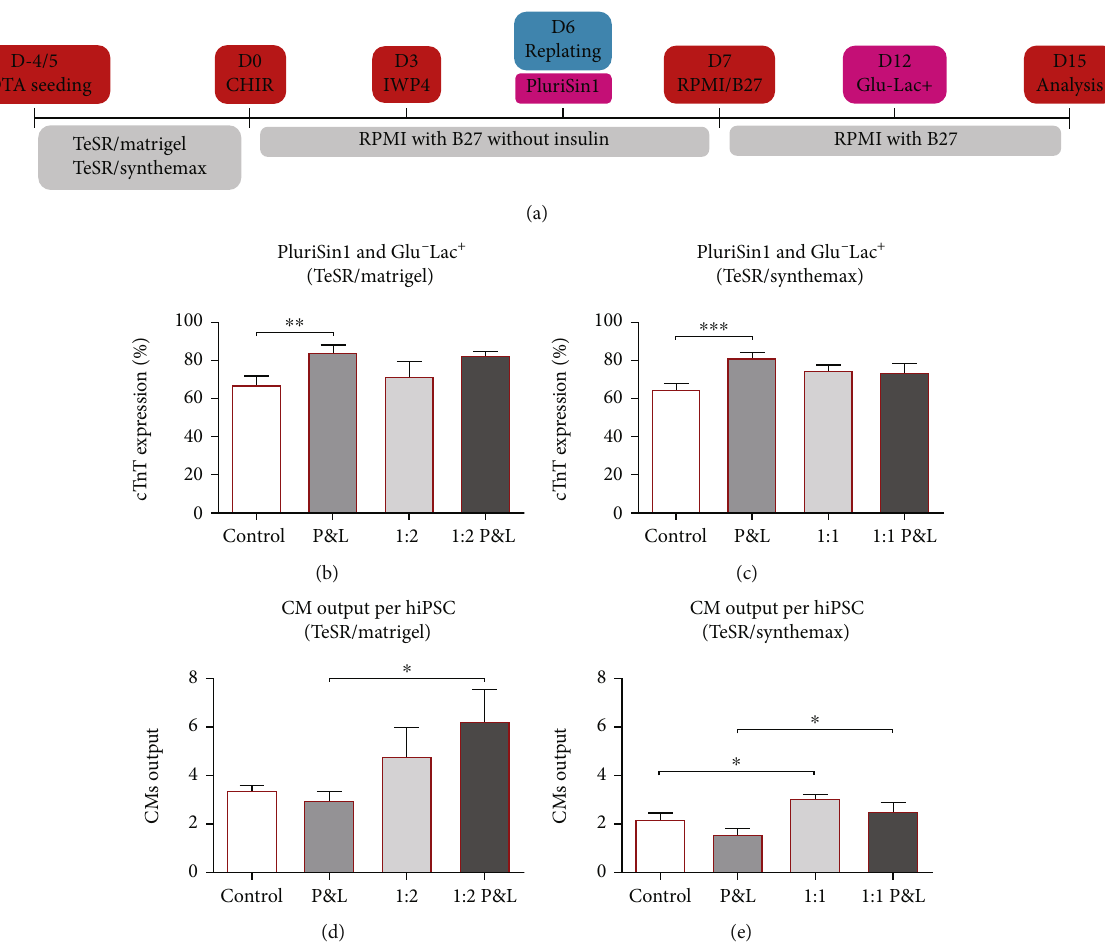
Figure 3: Integration in the di ff erentiation platform of a two-phase puri fi cation and enrichment step. (a) Addition of a puri fi cation step using 20 μ M of PluriSin1 at day 6 and a puri fi cation/enrichment step at day 12 using glucose-free medium supplemented with lactate (Glu - Lac + ). (b) Simultaneous introduction of the two-step Plurisin1 and Glu - Lac + (P&L) increased di ff erentiation e ffi ciency in the system TeSR/Matrigel when compared with control. Error bars, SEM: n = 12 for Control (6 μ M), n = 7 for P&L, n = 5 for 1: 2, n = 6 for 1:2 P&L. ∗∗ p value < 0.01 (Welch ’ s t -test). (c) Similar impact of Plurisin1 and Glu - Lac + was observed for the system TeSR/Synthemax when compared with control. Error bars, SEM: n = 7 for Control (6 μ M) and P&L, n = 10 for 1 :1, n = 6 for 1 :1 P&L. ∗∗∗ p value < 0.001 (Welch ’ s t -test). (d) CM output at day 15 per seeded hiPSC for the system TeSR/Matrigel was not impacted signi fi cantly by P&L unless when replating was performed. Error bars, SEM: n = 8 for Control (6 μ M) and 1:2, n = 6 for P&L and 1 :2 P&L. ∗ p value < 0.05 (Welch ’ s t -test). (e) Similarly, CM output for the system TeSR/Synthemax was not impacted signi fi cantly by P&L unless replating was performed. Error bars, SEM: n = 7 for Control (6 μ M) and P&L, n = 6 for 1:1 and 1:1 P&L. ∗ p value < 0.05 (Welch ’ s t